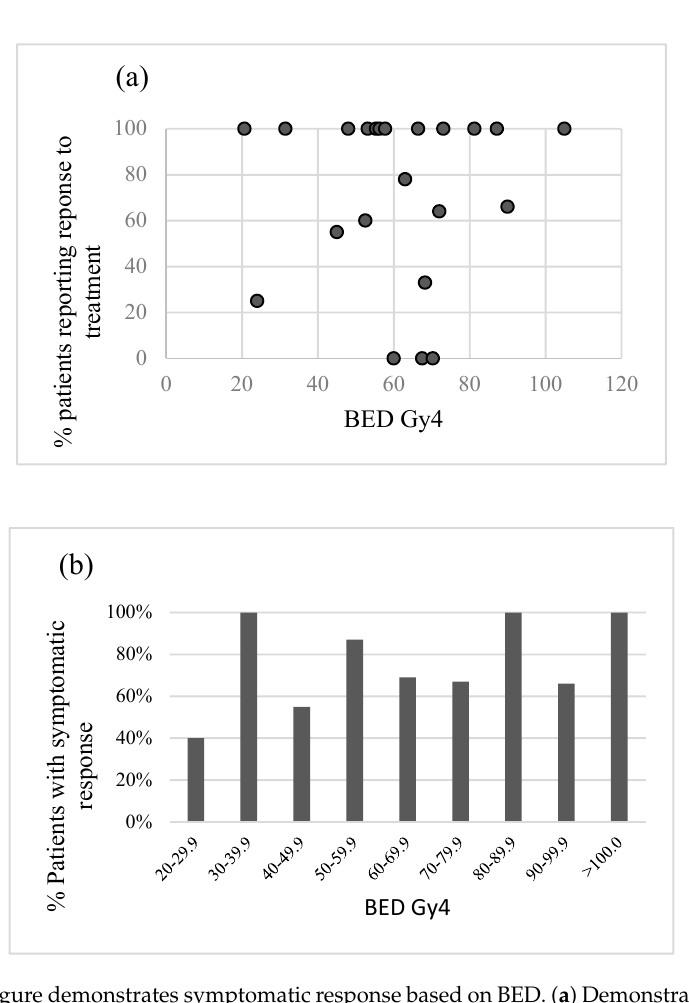
Figure 3. This figure demonstrates symptomatic response based on BED. ( a ) Demonstrates the response for each separate dose and fractionation regimen, expressed as its BED (Gy 4 ); ( b ) demonstrates the response for all dose and fractionation regimens with a BED within each given range.